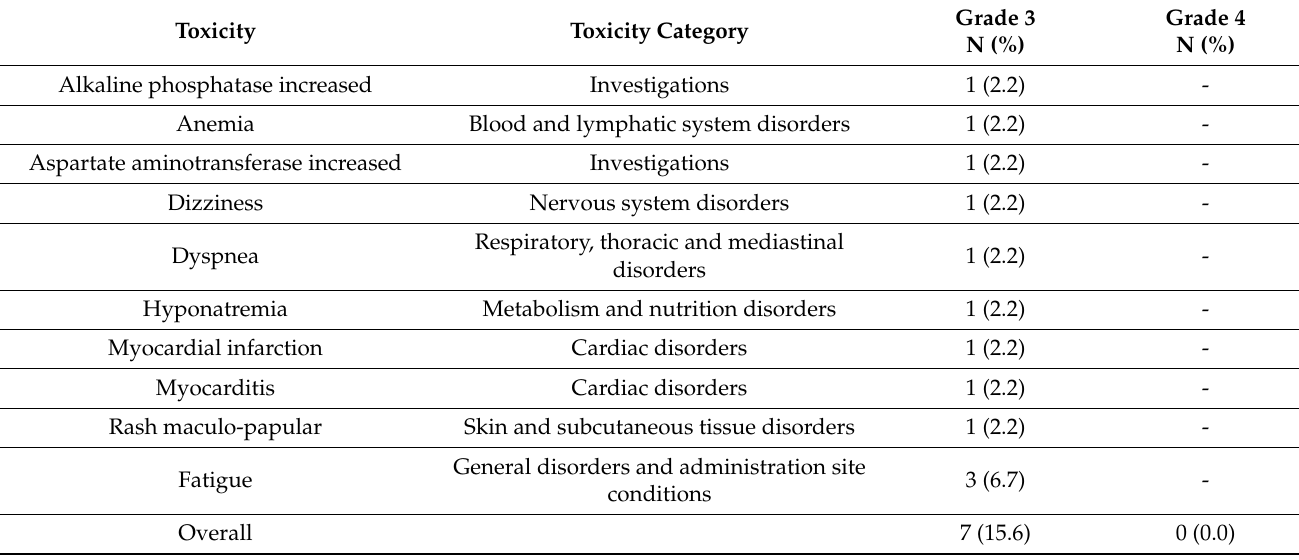
Table 3. Immune-Related Adverse